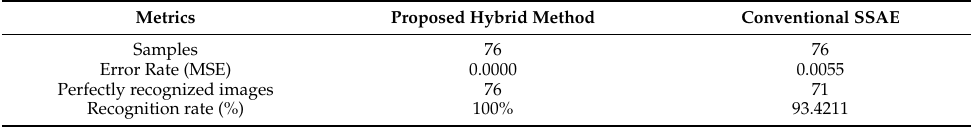
Table 6. Performance comparison for the Extended Yale-B